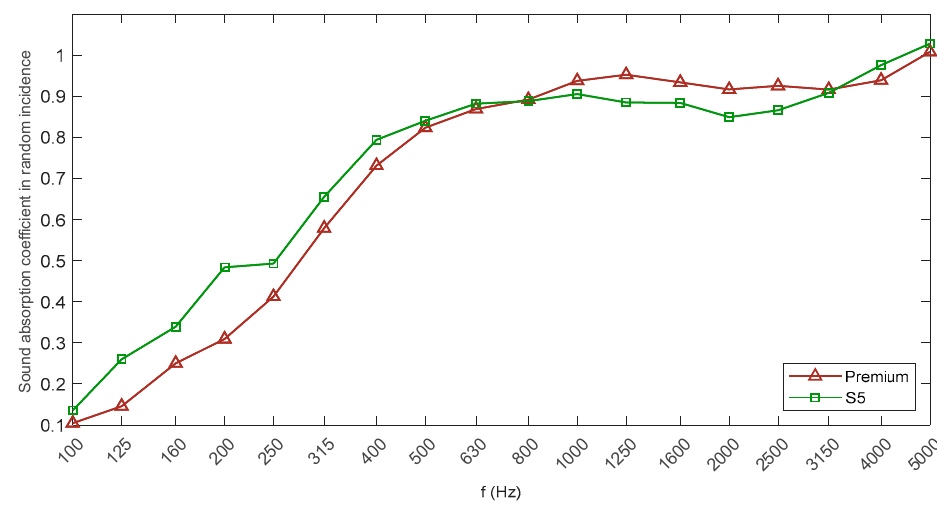
Figure 8. Sound absorption coefficient in random incidence of Premium and S5 sheep wools.